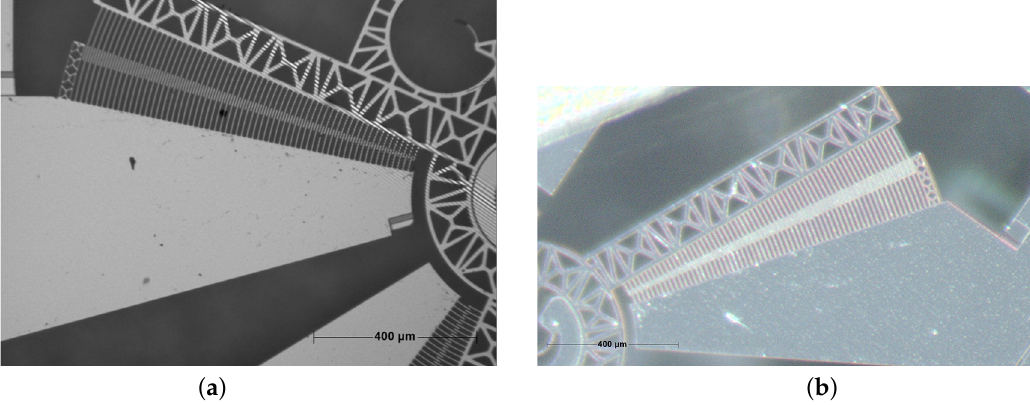
Figure 5. Two examples of images of the Microgripper comb-drive, acquired by optical profilometer ( a ), and optical microscope ( b ); both images ( a , b ) are referred to 0